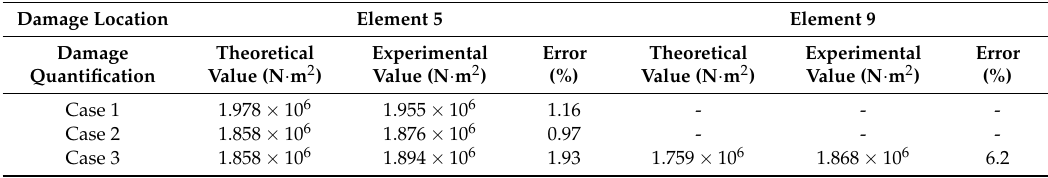
Figure 5. Damage location for Level 1. ( a ) Case 1; ( b ) Case 2; ( c ) Case 3. Table 1. Damage quantification